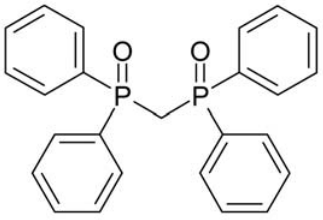
–Am 3+ (microamounts)–nitro- 3 ) = 0.05 mol/L, c = 0.0025 mol/L. 3 B ]/ c(Am 3+ ) ]/ c(Am 3+ ) , 2 δ( Am 23+ ) = [ AmL 3+ , org 2,org org org ]/ c(Am 3+ ) ] + , where c(Am 3+ ) = [ Am 3+ 3,org org org org